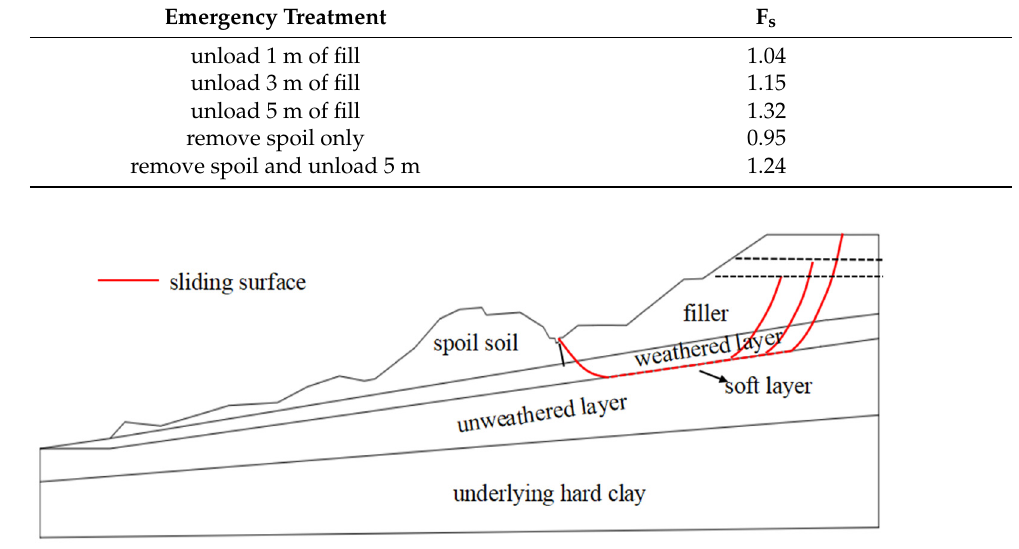
Table 6. Stability coefficient after taking emergency treatment measures.